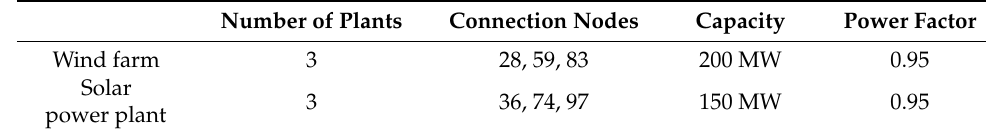
Table 1. Parameters of wind and solar power.